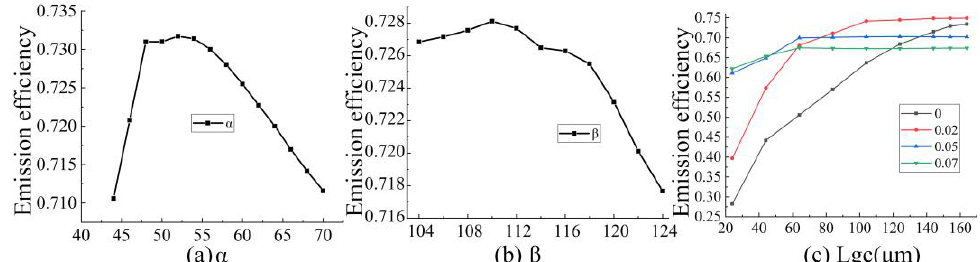
Figure 5. The fabrication tolerance in relation to grating coupler etches at α and β angle. ( a ) The emission efficiency of the proposed antenna under the condition that α has 5 – 10% error with the exact value; ( b ) the emission efficiency of the proposed antenna under the condition that β has 5 – 10% error with the exact value; ( c ) transmitting efficiency of the proposed antenna for different over-etching depths.